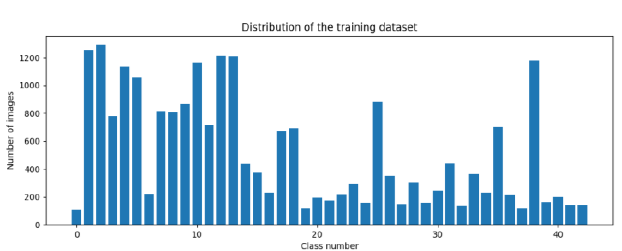
Fig. 7. Bar graph representing number of images per class Fig.7 Represent the Distribution of Images among 43 classes.